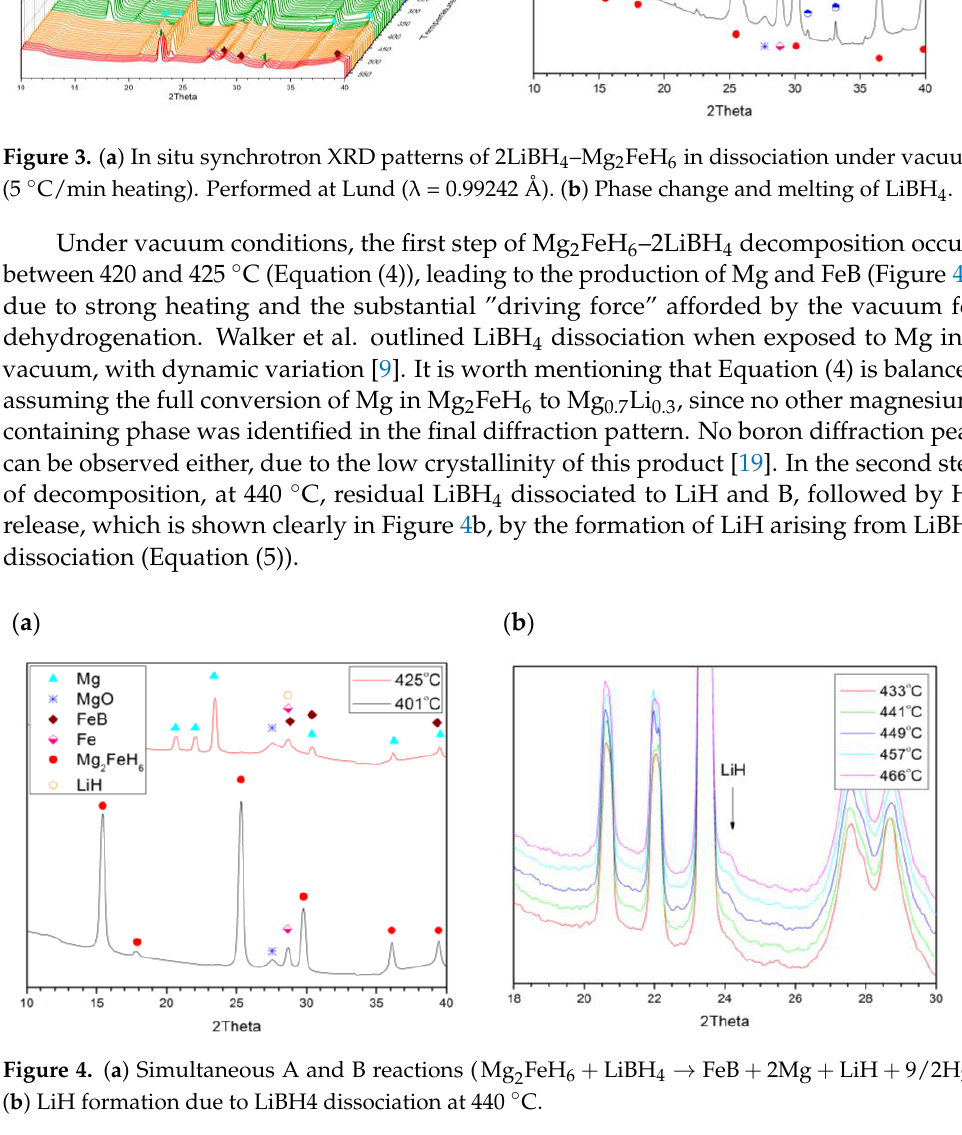
FeH 6 + LiBH 4 → FeB + 2Mg + LiH + 9/2H 2 ). 2